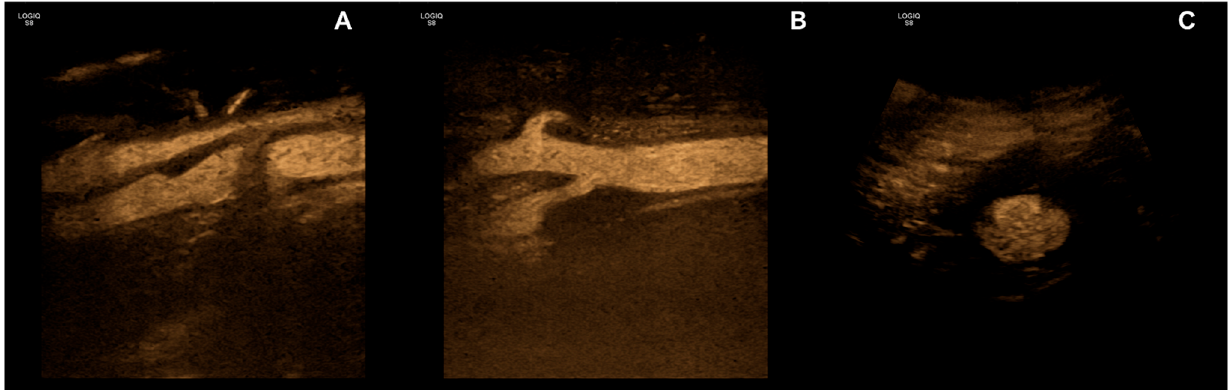
Figure 3. Examples of vascular pathologies visualized with B-Flow, carotid artery stenosis with calcified ( A ) and soft plaque ( B ) as well as abdominal aortic aneurysm with mural thrombus ( C ).